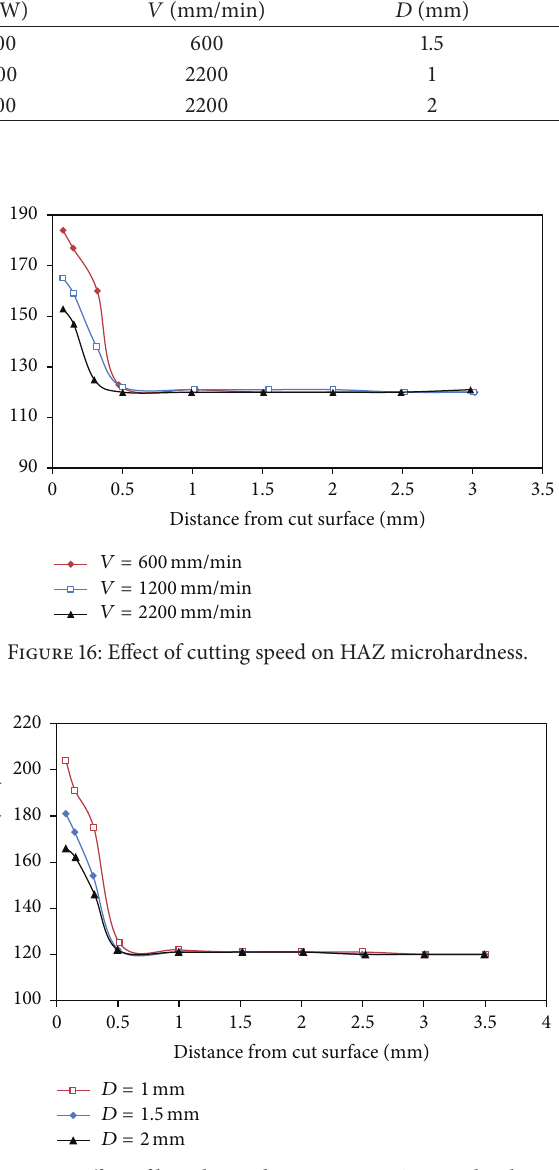
Figure 17: Effect of laser beam diameter on HAZ